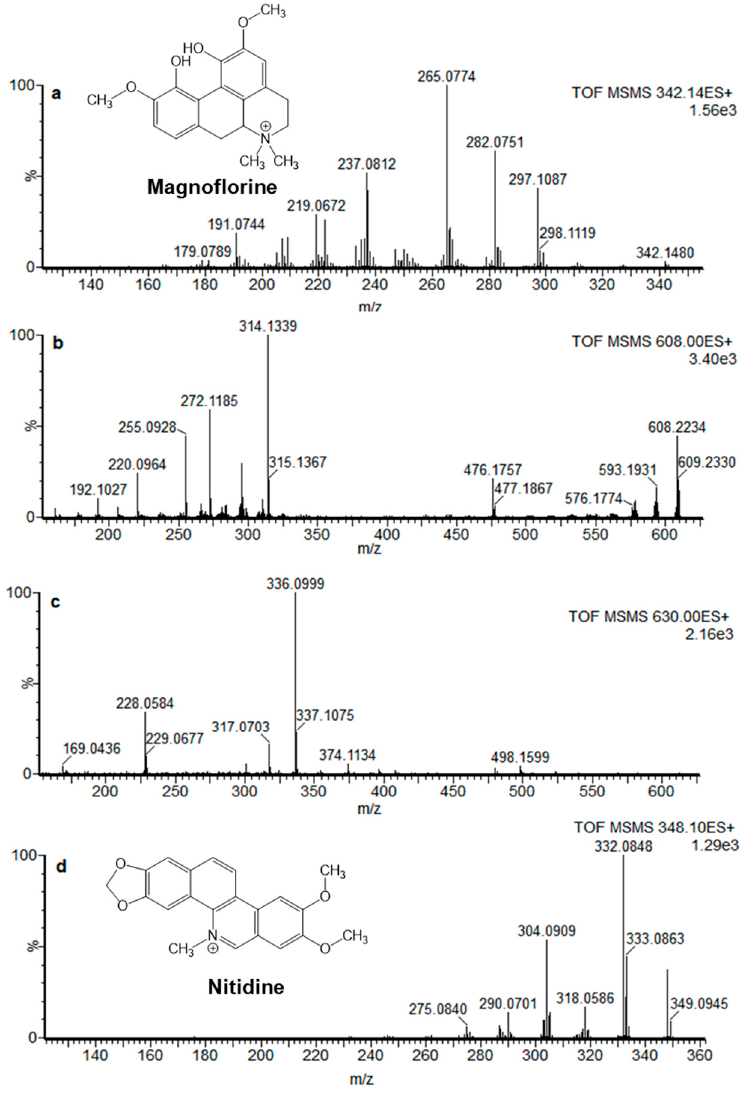
Figure 3. Product ion mass spectra of ( a ) PC1, ( b ) PC2a, ( c ), PC2b, and ( d ) PC3 fraction diluted in methanol and achieved by directed infusion on LC-ESI-Q-TOF. PC1 was identified as magnoflorine, while PC3 was identified as nitidine.